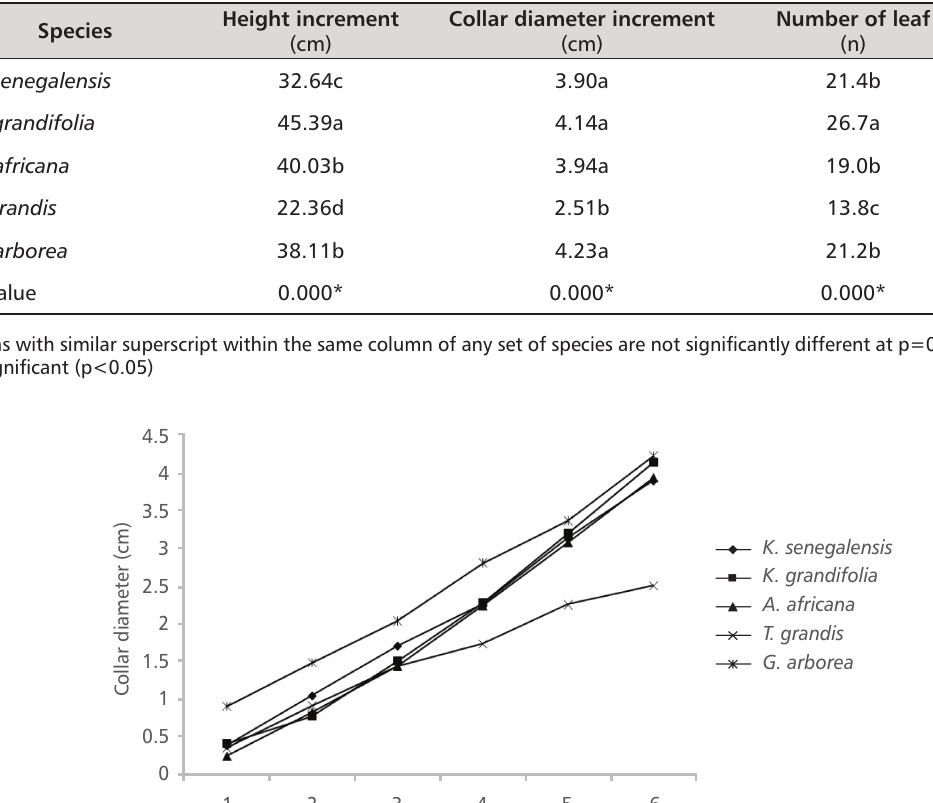
FIGURE 1. Height growth of the species after six months TABLE 1. Increase in height, collar diameter and number of leaf of tree saplings